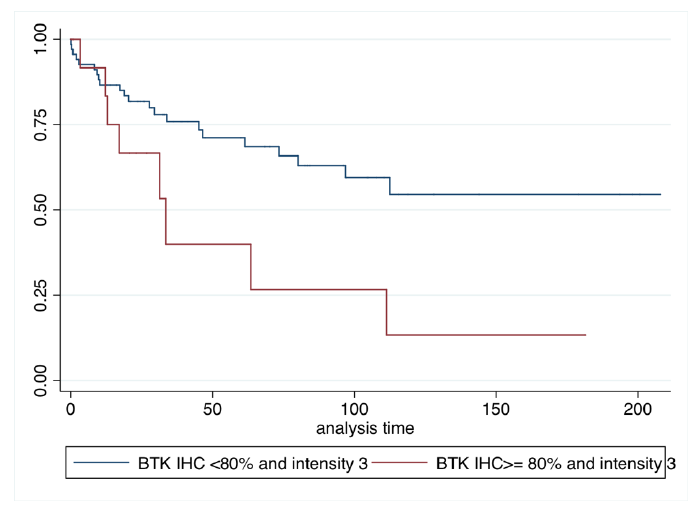
Figure 4. Kaplan–Meier overall survival (OS). Figure 4. Kaplan – Meier overall survival (OS). Figure 4. Kaplan – Meier overall survival (OS).